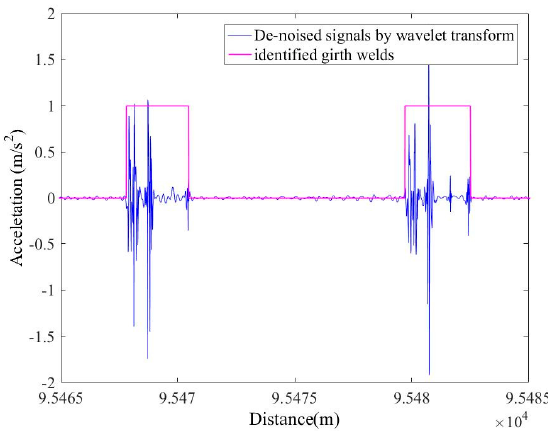
Figure 11. Zoom-in of identification of pipeline girth welds.